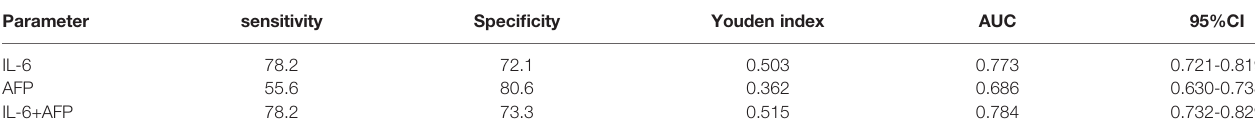
TABLE 4 | Diagnostic values of the IL-6 methylation level and the combined determination with AFP for distinguishing HBV-associated HCC from CHB.